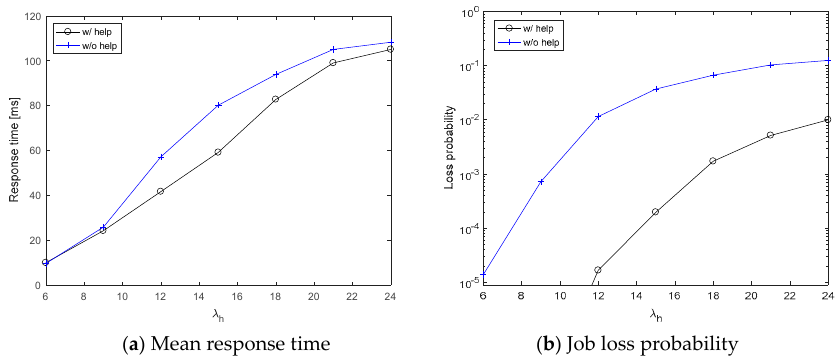
Figure 8. Dependence of application-level QoS parameters on the job arrival rate during alarm states.